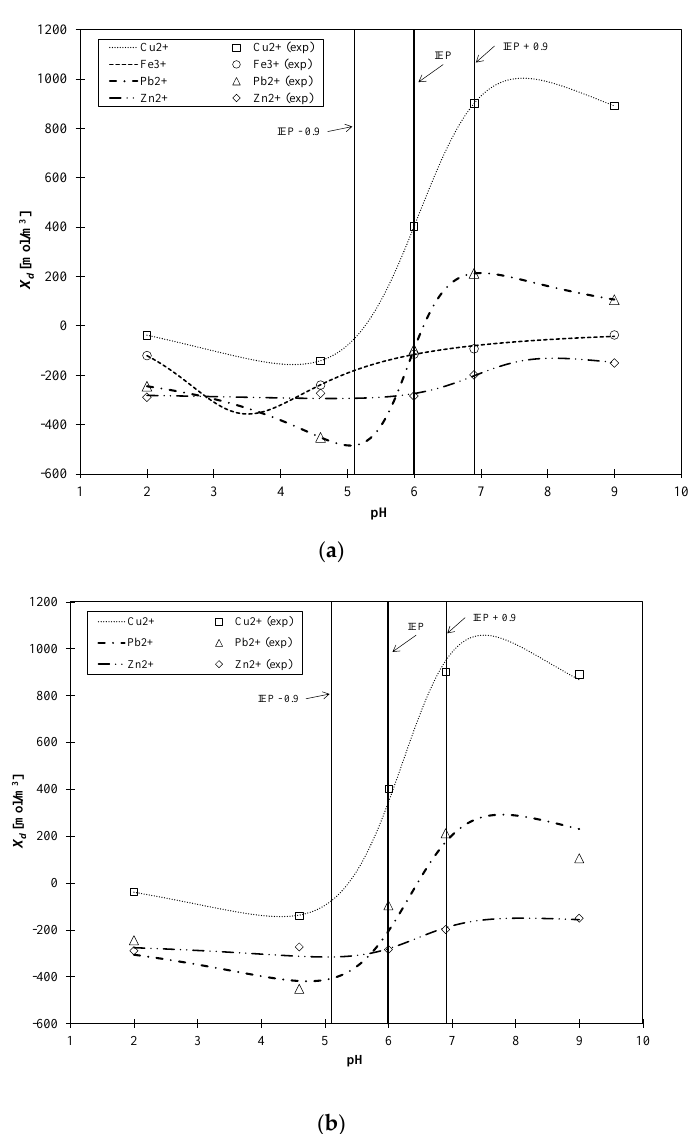
Figure 9. Performance of correlation Equation(20), with parameters listed in Table 6, with respect to estimated X d values. ( a ) first set of parameters from Table 6; ( b ) second set of parameters from Table 6.